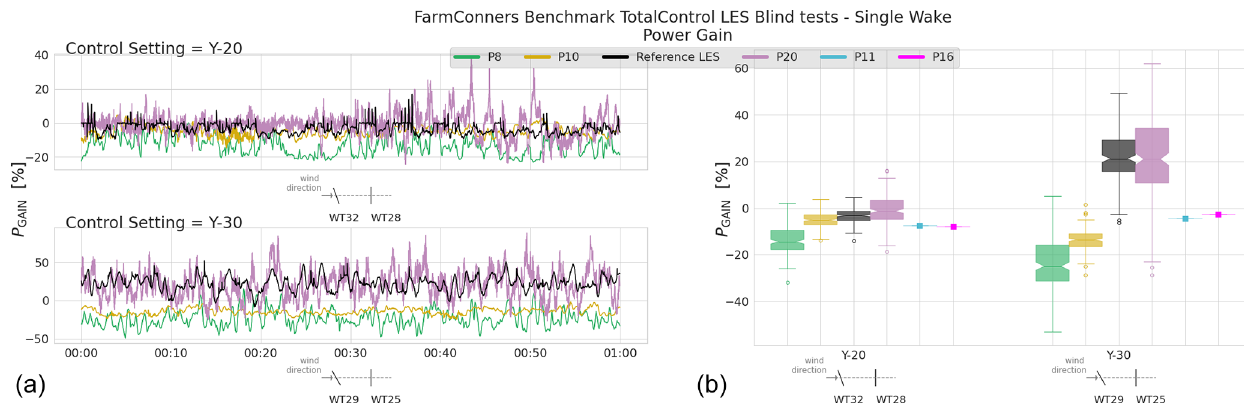
Figure 23. TotalControl LES blind tests, power gain, P GAIN , estimations for single wake under wake steering for the two-turbine configu- rations with 5D spacing (WT32–WT28 with 20 ◦ yaw and WT29–WT25 with 30 ◦ yaw at the upstream turbines). (a) Time series of P GAIN , illustrated at the submitted frequency by the participants, for both control scenarios. (b) The distribution of the P GAIN within the 1h blind test period for both 20 and 30 ◦ anticlockwise yaw misalignment WFFC